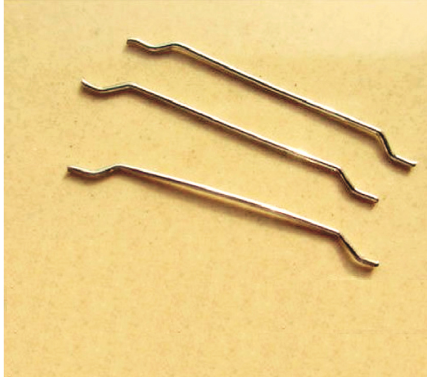
Figure 1: Hooked-end shape steel